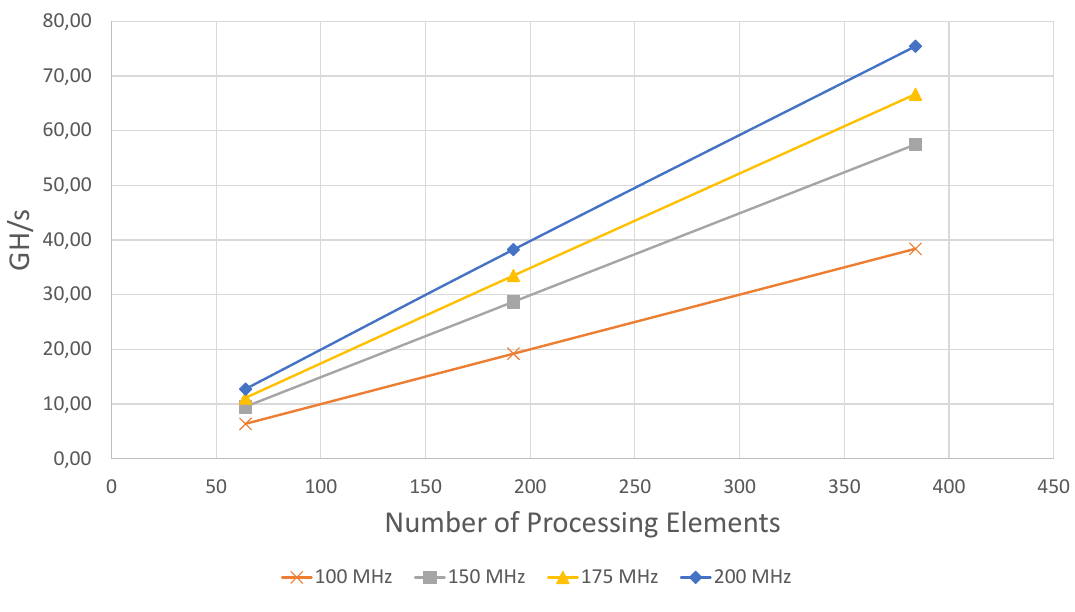
Figure 6. Graphical representation of Table